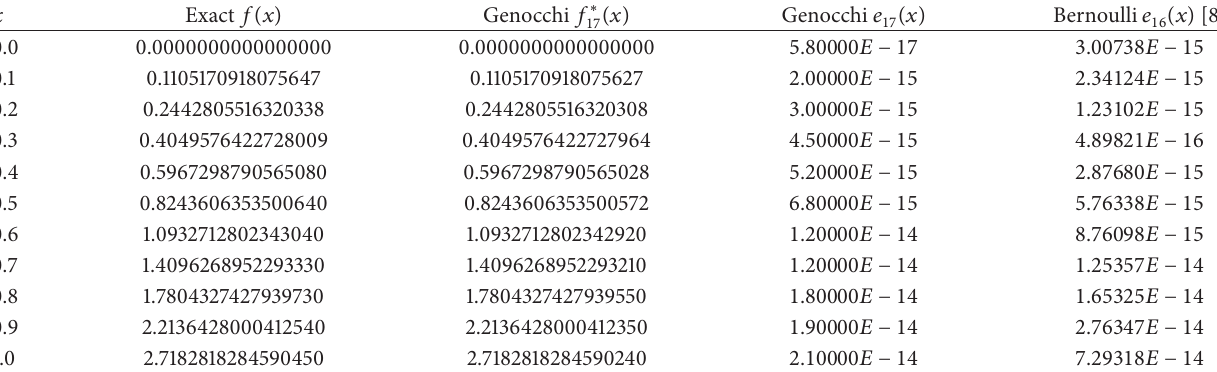
Table 4: Comparison of absolute errors for Example 2 using 𝑁 = 17 orders of Genocchi polynomials and Bernoulli method 𝑁 = 16 [8].